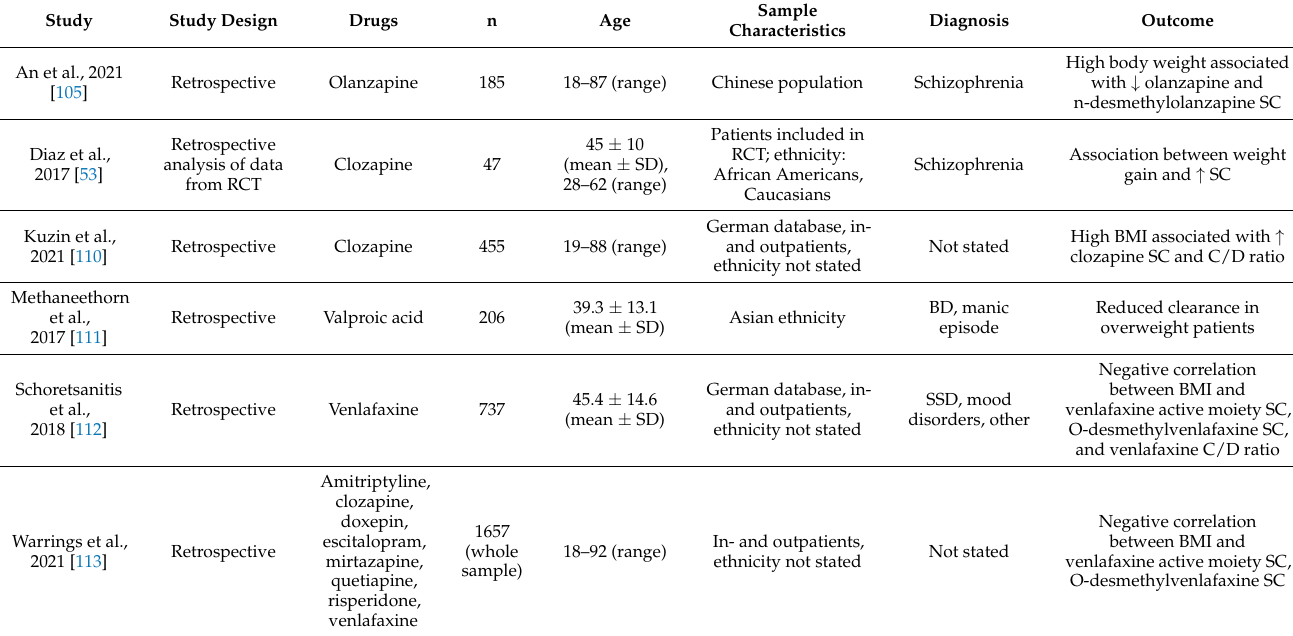
Table 7. Original articles on the use of TDM in patients with abnormal body